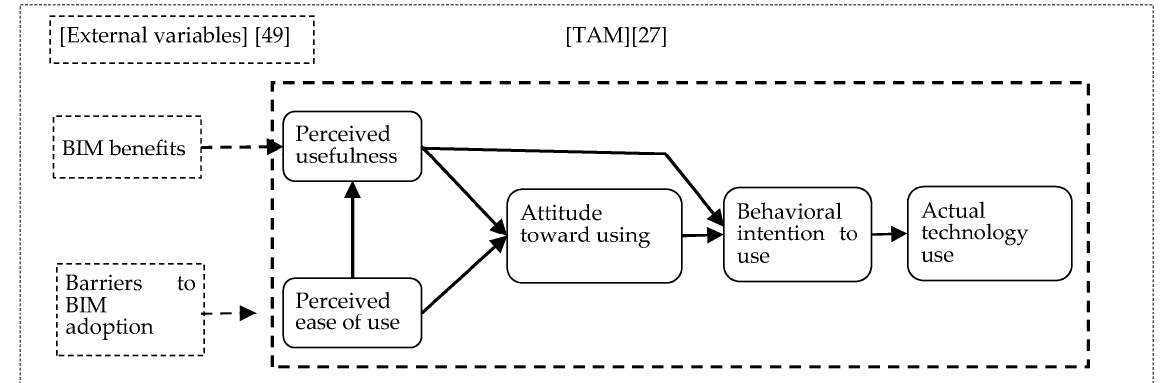
Figure 2. BIM benefits and barriers as external variables for a recommended further research on the impact of perceived usefulness and ease of use of the technology on its acceptance and actual use in the construction industry using the technology acceptance model [TAM].